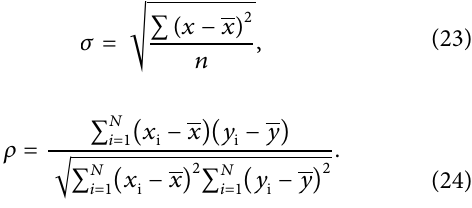
Figure 8: The data examples analysis. (a) 𝑄 (c) 𝑄 main = 1868 veh / h ∗ l , 𝑄 in = 700 veh / h ∗ l , (d) 𝑄 main = 1868 veh / h ∗ l , 𝑄 in = 1000 veh / h ∗ l